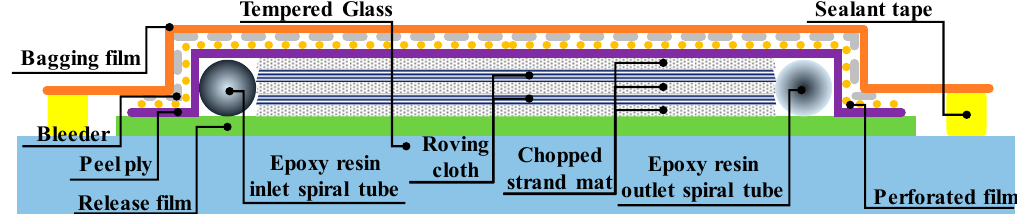
Figure 7. Schematic of the vacuum infusion bagging method.